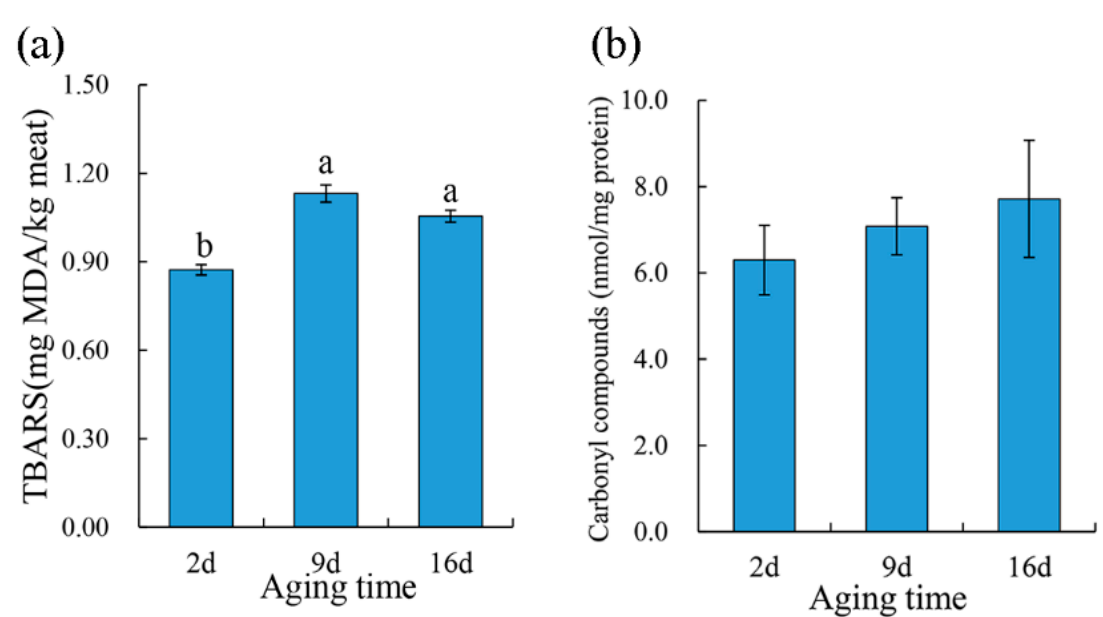
Figure 3. The effect of aging treatments on lipid ( a ) and protein ( b ) oxidation of pork meat. Results are expressed as the mean ± standard error. Means with different letters (a,b) are different ( p < 0.05).